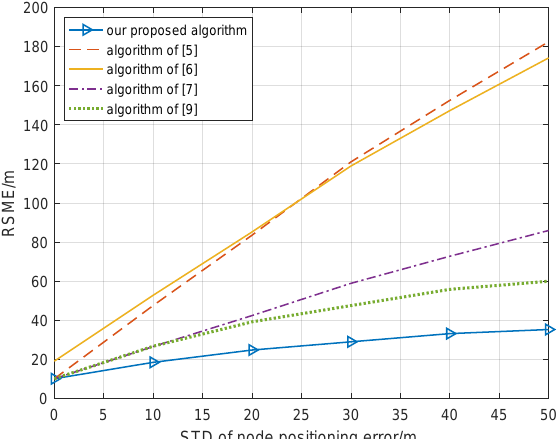
Figure 5. Relationship cooperative position error and node positioning error, wherethe STD of ranging error is 10